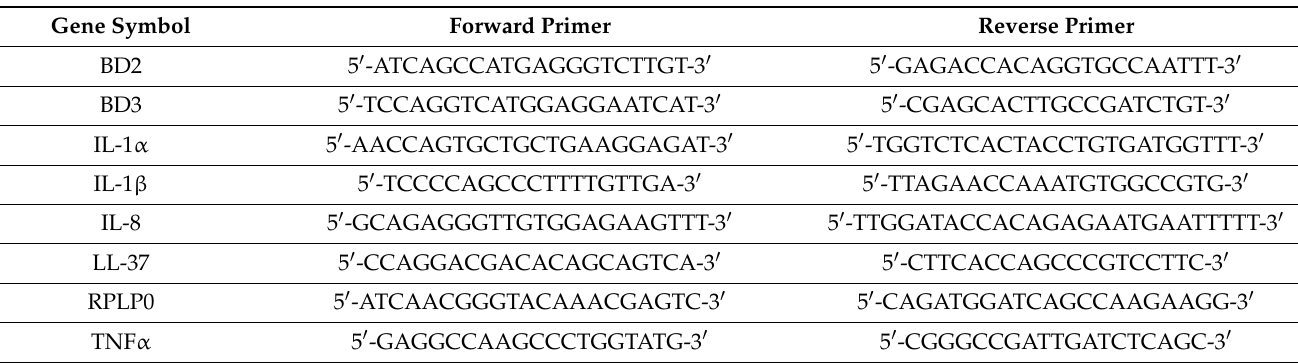
Table 3. Sequences of primer pairs used for